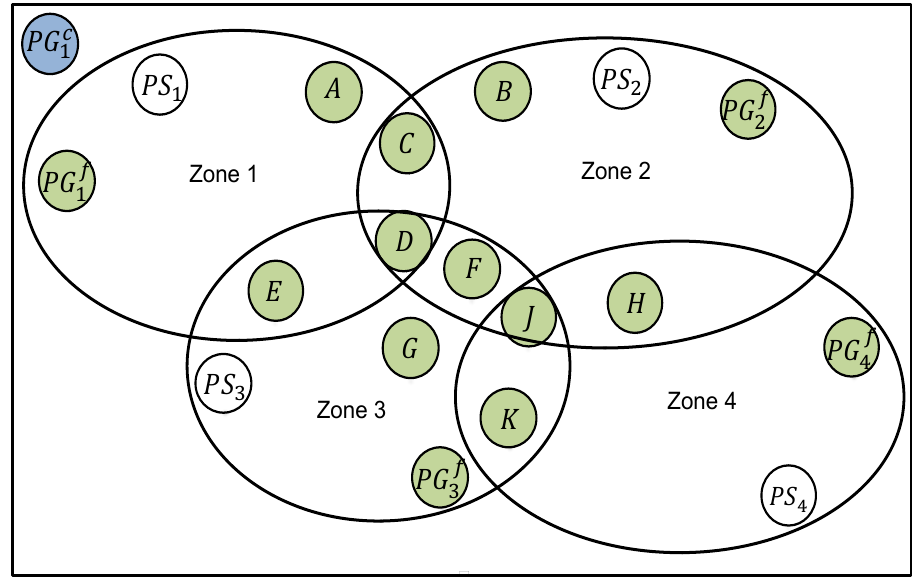
Figure 16. Simulation scenario consists of power loads, generators, storage devices for each zone and a shared power grid.